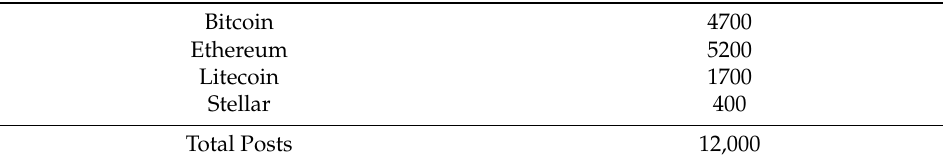
Table 2. Number of posts per cryptocurrency.